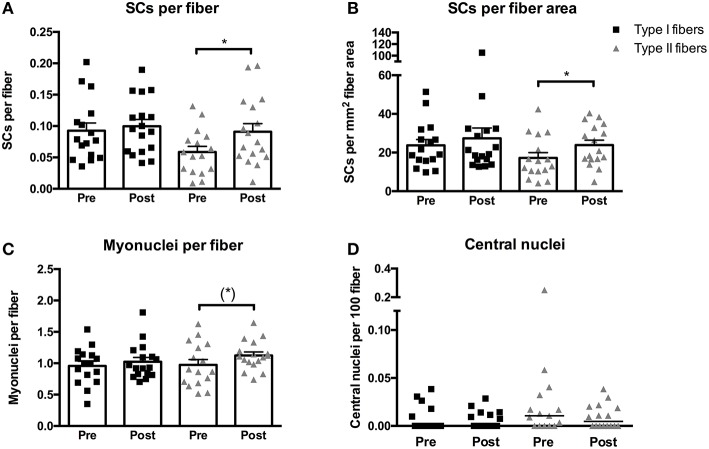
Satellite cells (SCs) associated with type I or II fibers expressed per fiber (A) or per mm2 fiber area (B), myonuclei per fiber (C), and central nuclei per fiber (D) evaluated from biopsies obtained pre- and post-training in multiple sclerosis patients. Data are presented as individual values and mean ± SEM (A–C) or individual data-points and median bar (D). Significant differences from pre to post are denoted by *p < 0.05 and tendencies by (*) p = 0.06.